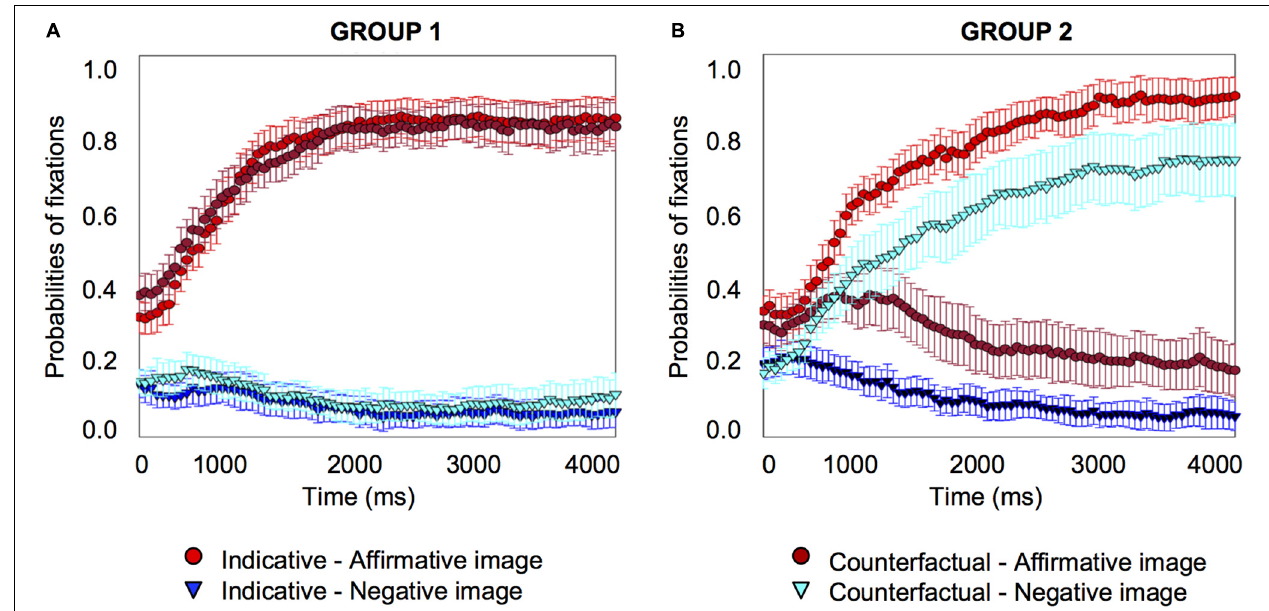
FIGURE 9 | Individual differences probabilities of fixations for indicative and counterfactual sentences for the subset group of 30 participants who looked more frequently at the affirmative image or printed words for counterfactuals (A) , and the second subset group of 33 participants who looked more frequently at the negative one for counterfactuals (B) in all experiments. Error bars are 95% confidence intervals within participants.